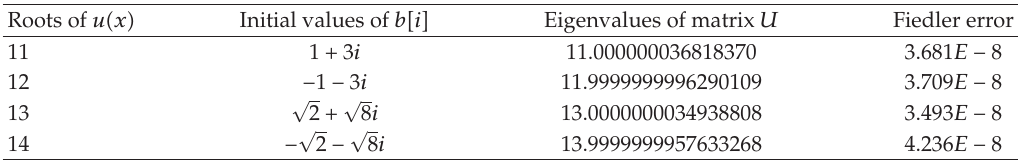
Table 3: Achieved roots of polynomial by choosing initial values on the